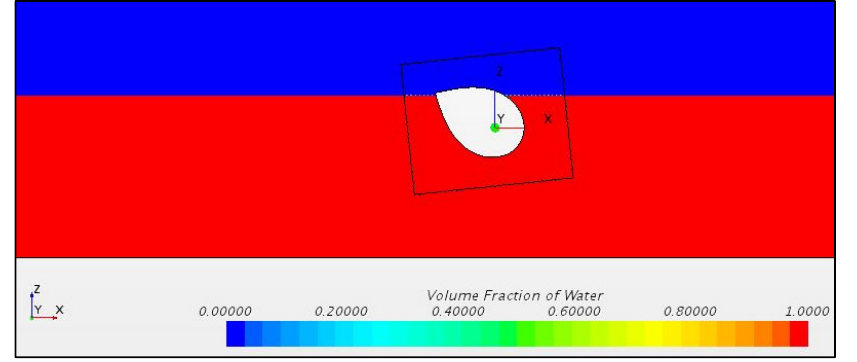
Figure 5. Initial mesh generation over the computational domain.